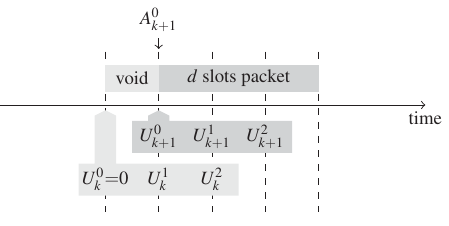
Figure 2: Two consecutive transmission opportunities, for d = 3 > 0 . and for U 0 k